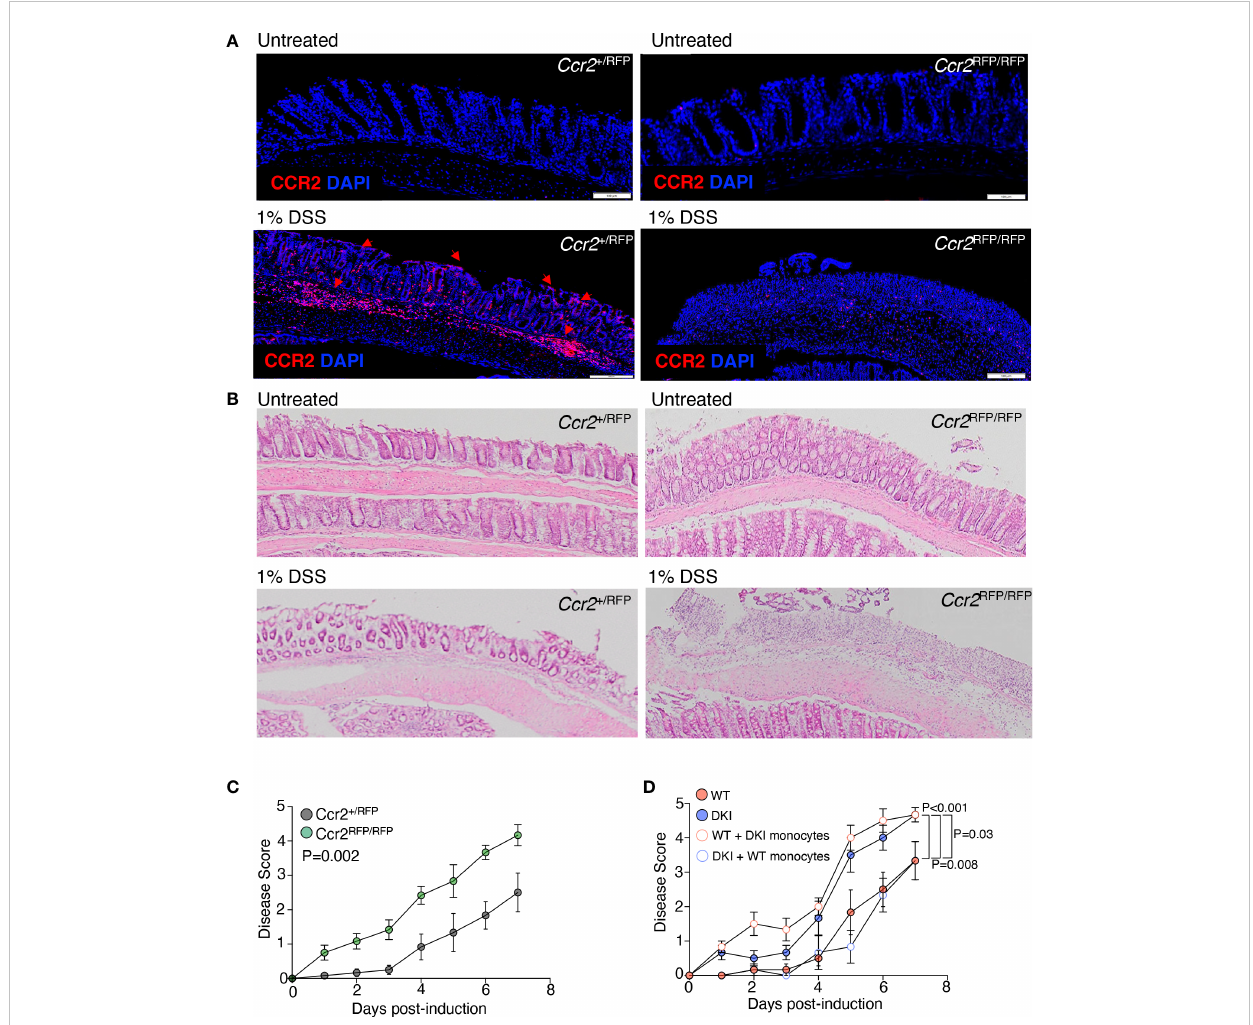
FIGURE 4 STAT5 Tetramers in Monocytes Regulate the Severity of Colitis. (A, B) Colon sections Ccr2 +/RPF and Ccr2 RFP/RFP mice with and without DSS treatment. (A) Representative images showing monocyte migration to the site damage in the epithelial monolayer following treatment with 1% DSS (red arrows). (B) Representative H&E-stained colon sections. Data are from 2 independent experiments with n=6. (C) Ccr2 +/RFP and Ccr2 RFP/RFP mice were treated with 1% DSS for 7 d. Disease scores are shown. Data are from 4 independent experiments with n=13 for WT and 12 for DKI. (D) WT and DKI monocytes were transferred into WT and DKI recipient mice on days 0 and 2 following treatment with 1% DSS. Colitis disease scores are shown. Data are from 2 independent experiments with n=6. (C, D) Data shown are mean ± SEM. Statistical signi fi cance is indicated by the P-value with NS meaning no statistical signi fi cance. (C) Area under the curve with unpaired t test. (D) Area under the curve with one way ANOVA and Tukey ’ s test for multiple